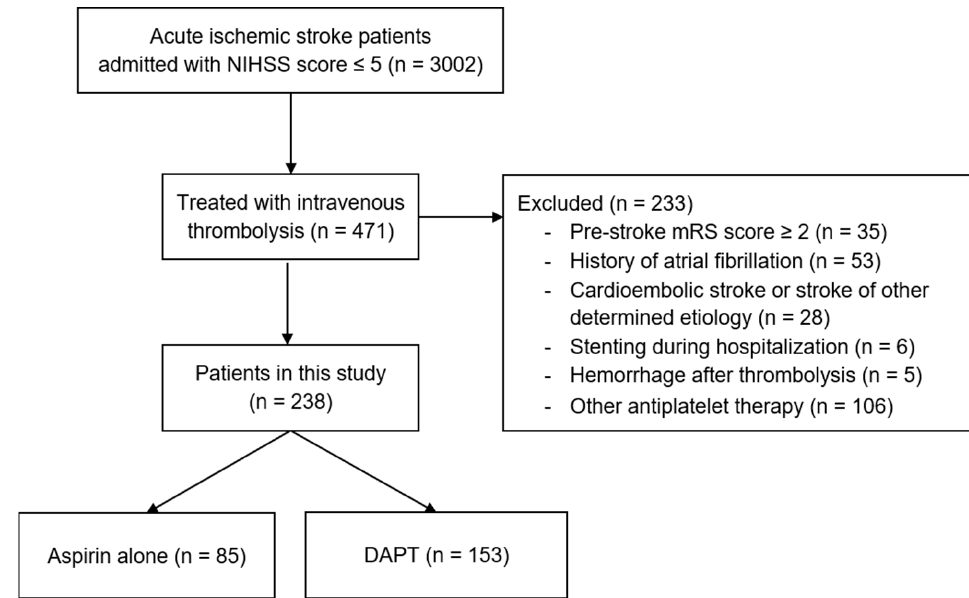
Figure 1. Flow diagram of patient recruitment within the stroke registry data. Table 1. Characteristics of patients with minor stroke treated with aspirin and DAPT after thrombolysis.